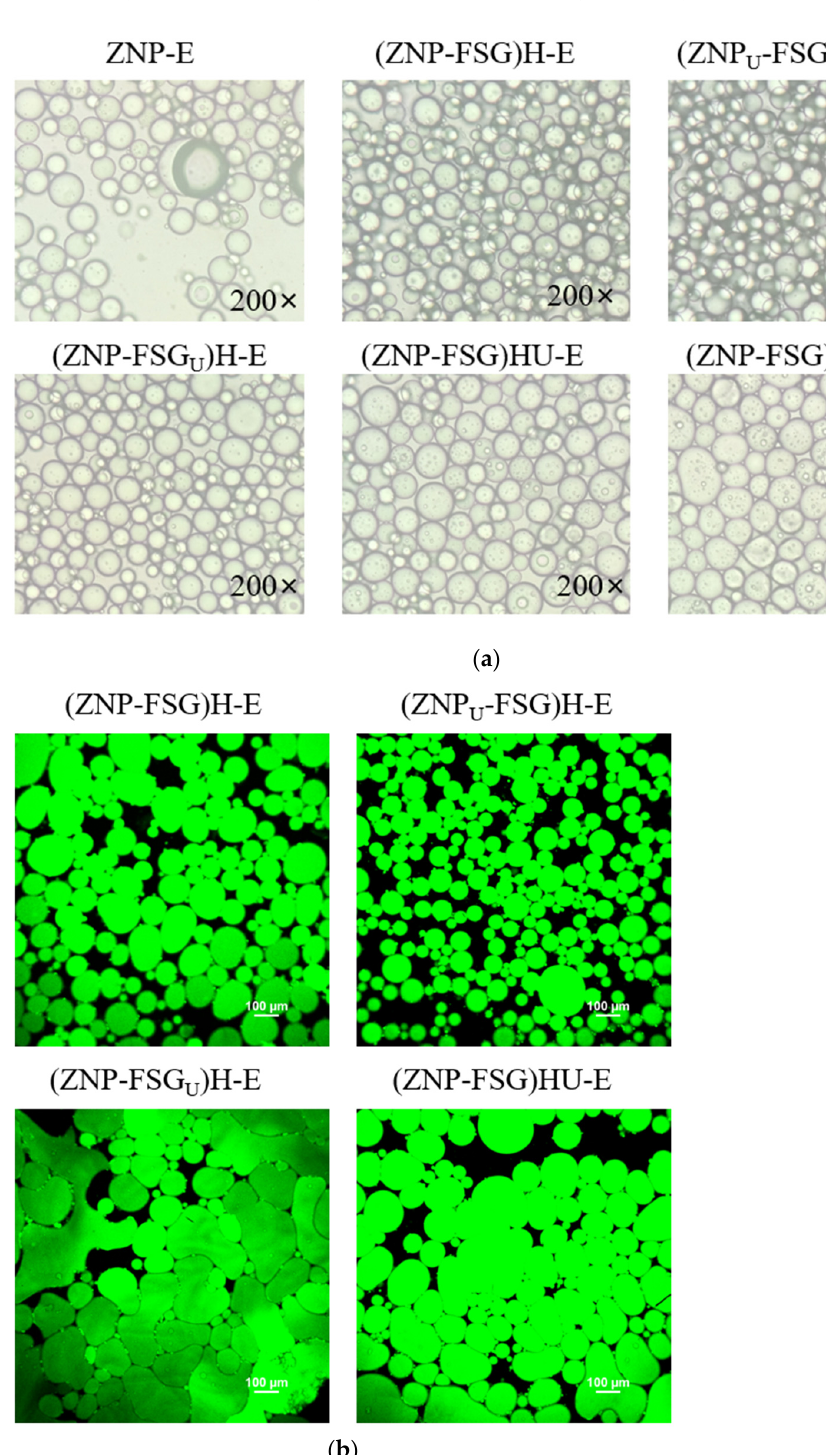
Figure 9. Optical micrographics ( a ) and Confocal laser scanning microscopy (CLSM) ( b ) of emulsions stabilized by ZNP and FSG complexes subjected to various ultrasound and homogenization treatments.